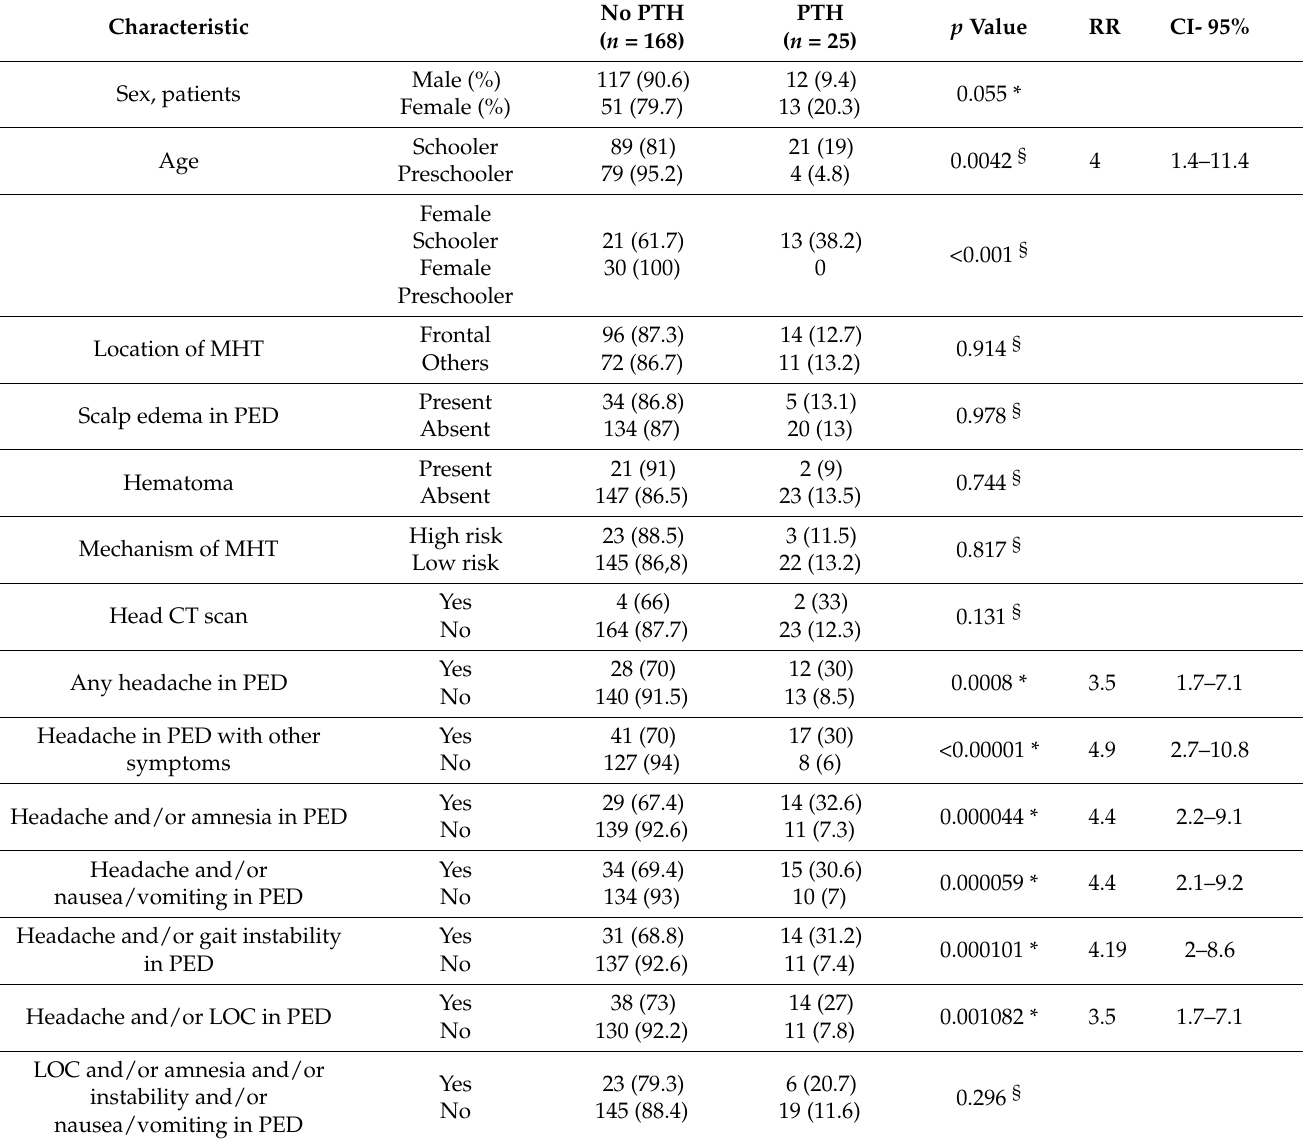
Table 3. Risk factors for post-traumatic headache (PTH) development in patients referred to the pediatric emergency department (PED) for minor head trauma (MHT). Data based on the initial telephone interview of 193 patients. Frequencies relate to the total number of patients with the same characteristics and in the same line (e.g., male patients with no PTH are 117, meaning 90.6% of all males). In the case of gait instability, orthopedic injuries were ruled out by physical and/or radiological examination. Amnesia includes loss of memory of the events both preceding and fol- lowing MHT. Mechanisms of MHT, high-risk: motor vehicle collision with patient ejection, death of another passenger, or rollover; pedestrian or bicyclist without helmet struck by motorized ve- hicle; falls >1.5 m; or head struck by high-impact object [3]. School age: ≥ 6 years old; pre-school age: <6 years old; RR: relative risk; CI: confidence interval; CT: computed tomography; LOC: loss of consciousness. * Yates’ correction has been applied, § Fisher’s exact